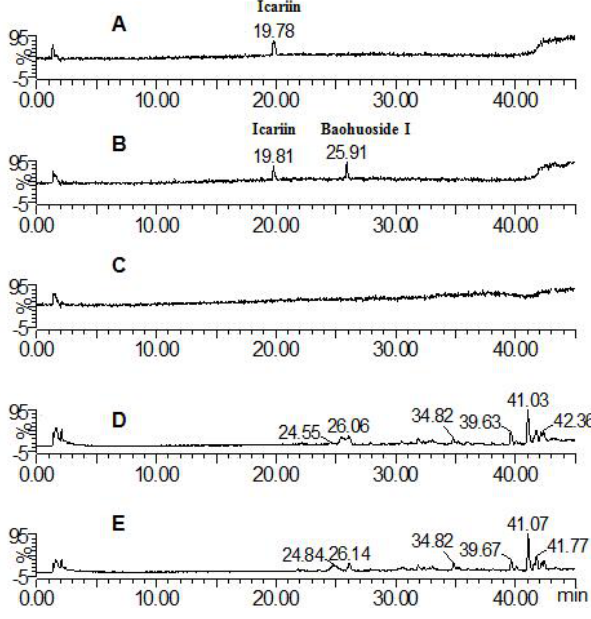
Figure 2. Mass spectrometry total ion current chromatograph for the icariin groups after 24 h (negative mode). A : icariin solution; B : icariin zebrafish solution; C : blank zebrafish group solution; D : zebrafish of icariin zebrafish group; E : zebrafish of blank zebrafish